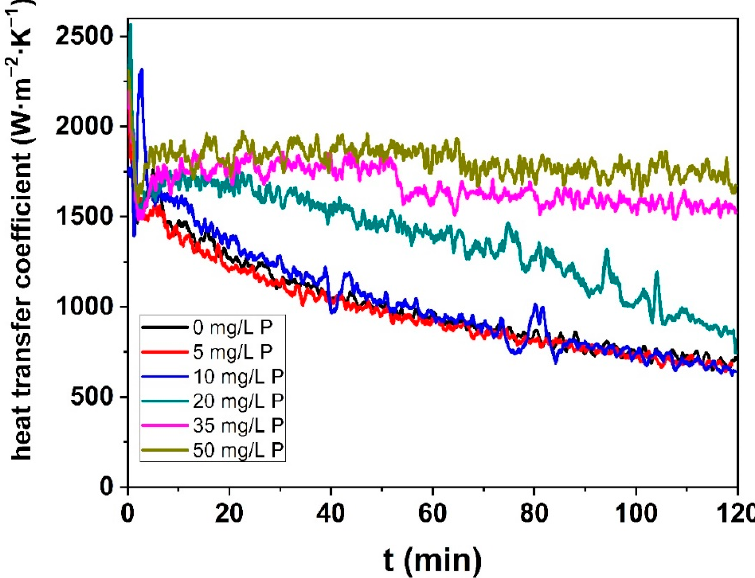
Figure 6. Heat transfer coefficient during fouling experiment for all phosphorus concentration in a 0.5% ( w / v ) WPI solution with a calcium concentration equal to <[Ca]> = 101.02 ± 2.06 mg/L.